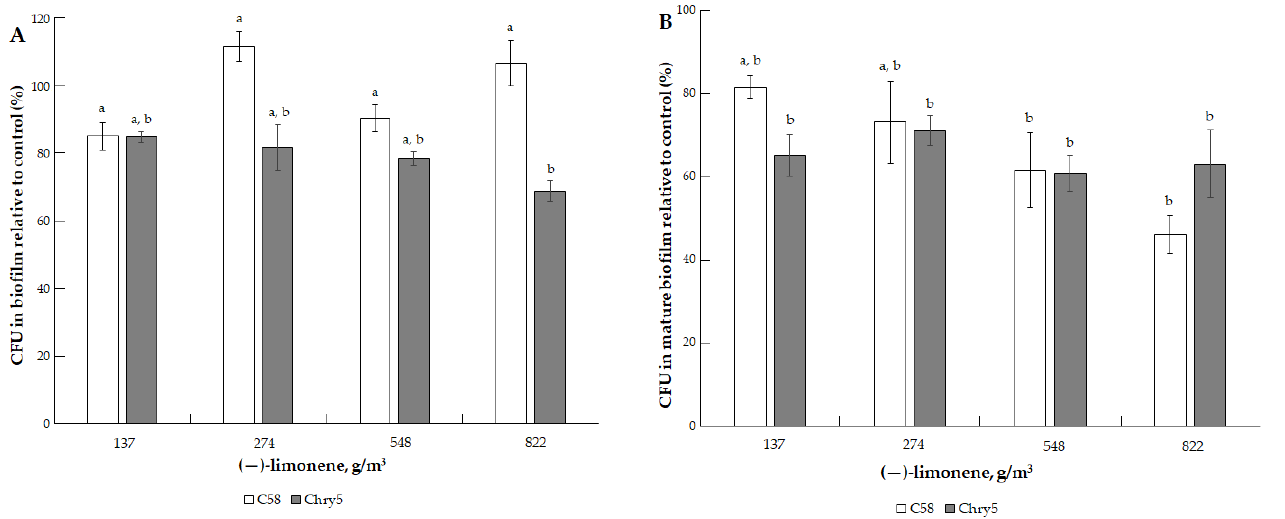
Figure 8. The effect of ( − )-limonene on the formation of biofilm of A. tumefaciens C58 (white column) and Chry5 (gray column) ( A ) and cell survival in mature biofilms ( B ) depending on the concentration of ( − )-limonene. CFU of bacteria strains in the control (without VOC): 100 a %. The different lowercase letters above the mean values indicate significant differences ( p ≤ 0.05; Tukey’s HSD test).